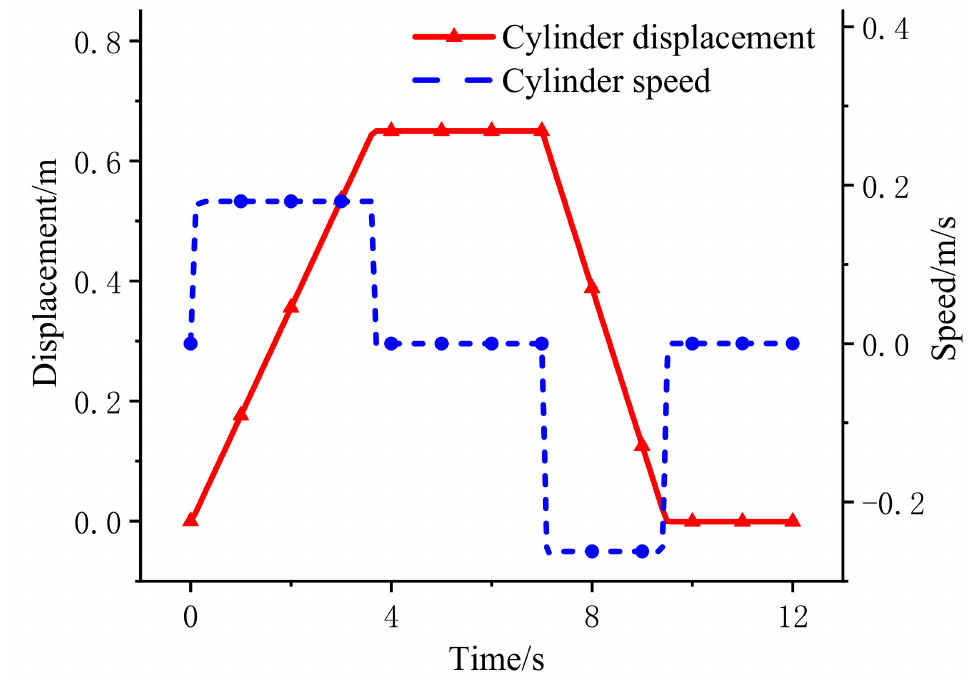
Figure 11. Curves of the displacement and speed of the boom cylinder.